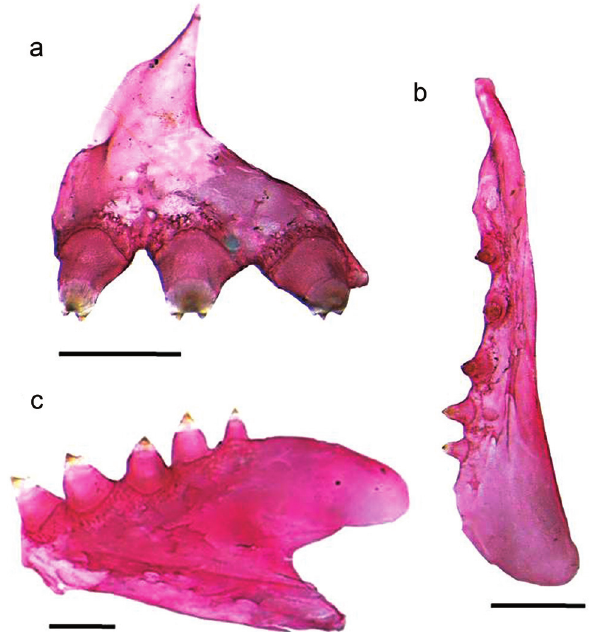
Fig. 1. Probolodus oyakawai , MZUSP 53499, paratype, 64.3 mm SL, teeth: a) Left premaxilla, anterior view; b) Left maxilla, lateral view; c) Left dentary, medial view. Scale bars = 1 mm.